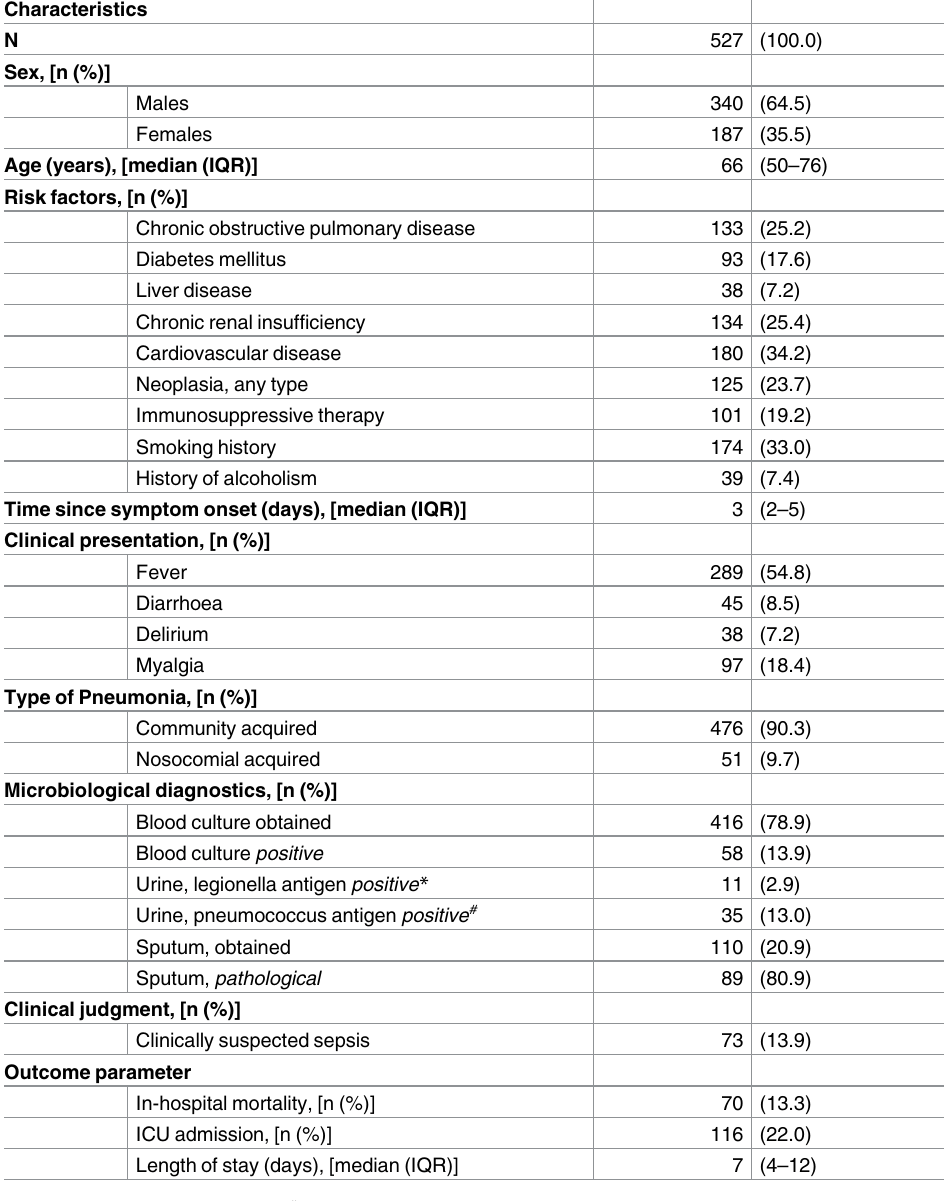
Table 1. Patient